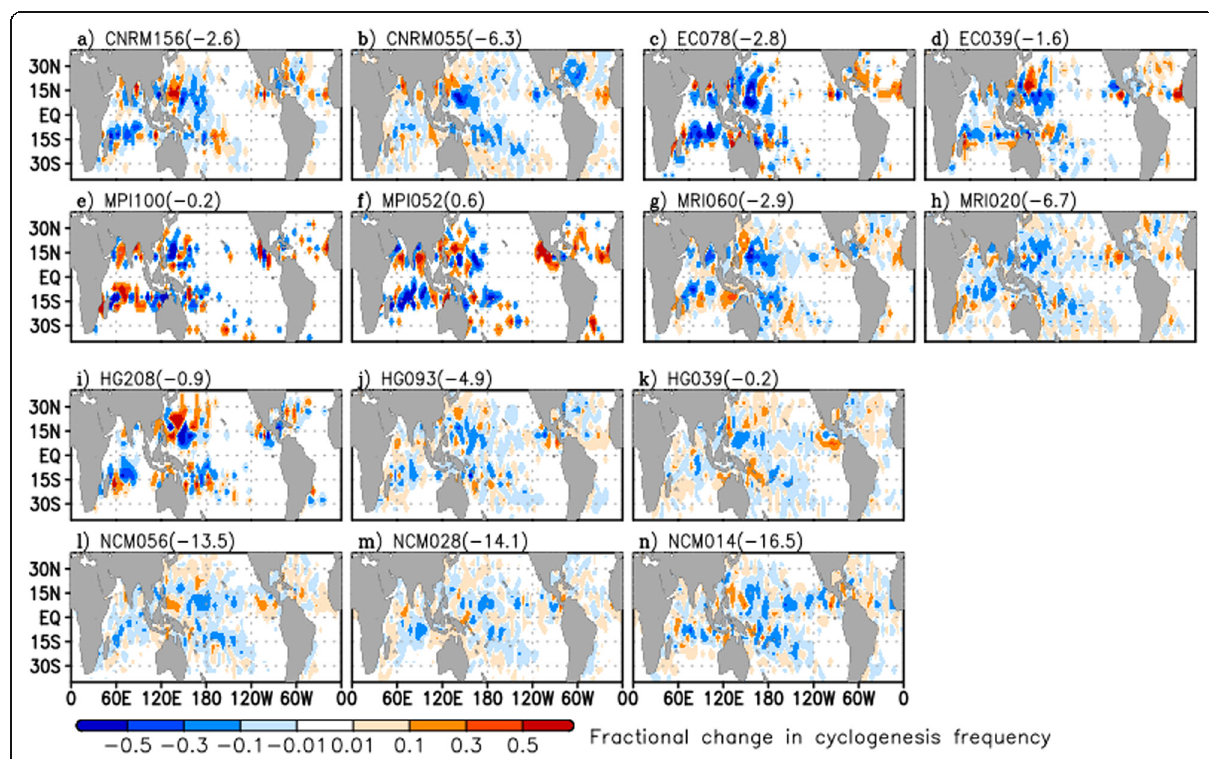
Fig. 3 Horizontal distributions of normalized future changes of TC genesis density. Panels show TC genesis densities of models: a CNRM156, b CNRM055, c EC078, d EC039, e MPI100, f MPI052, g MRI060, h MRI020, i HG208, j HG093, k HG039, l NCM056, m NCM028, and p NCM014. Future change was defined as a difference between 25-year mean values of TC genesis density in the future climate (2025 – 2049) and the present-day climate (1990 – 2014) except for NCM014. In the case of NCM014, the present-day climate spans 2000 – 2009, and the future climate spans 2040 – 2049. Red colors indicate an increase in TC genesis density. Blue colors indicate a decrease in TC genesis density. Genesis density was defined as the number of TCs per year generated in a 5°×5° grid box. The numbers in parentheses are changes in the global annual TC genesis frequency for each